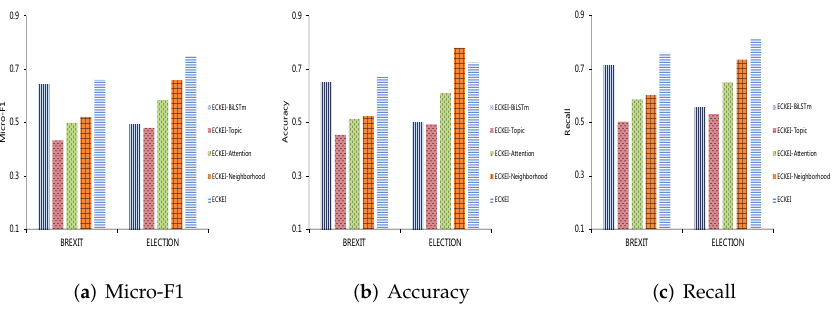
Figure 12. Micro-F1, Accuracy and Recall ablation results on two datasets for the opposing stance.